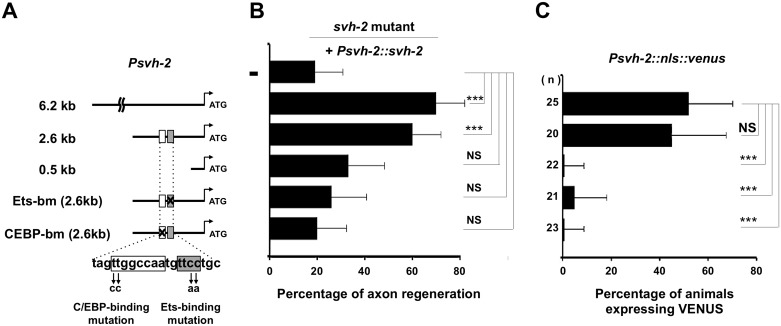
Promoter analysis of the svh-2 gene.(A) The svh-2 promoter region. Schematic diagram of the svh-2 transgenes used in rescue experiments are shown. The positions of binding sites for Ets and C/EBP in the svh-2 promoter are indicated by shaded and white boxes, respectively. (B) Identification of the svh-2 promoter region required for axon regeneration. Each construct was transfected into svh-2 mutants and analysed for axon regeneration. The percentages of axons that initiated regeneration 24 hr after laser surgery are shown. Error bars indicate 95% SI. ***P<0.001; NS, not significant. (C) Identification of the svh-2 promoter region required for induction of Psvh-2::nls::venus expression in D-type motor neurons by laser surgery. Each construct was transfected into animals and analysed for svh-2 gene induction in response to laser surgery. The percentages of animals expressing Psvh-2::nls::venus in D-type motor neurons following laser surgery are shown. The numbers (n) of animals examined are shown. Error bars indicate 95% SI. ***P<0.001; NS, not significant.